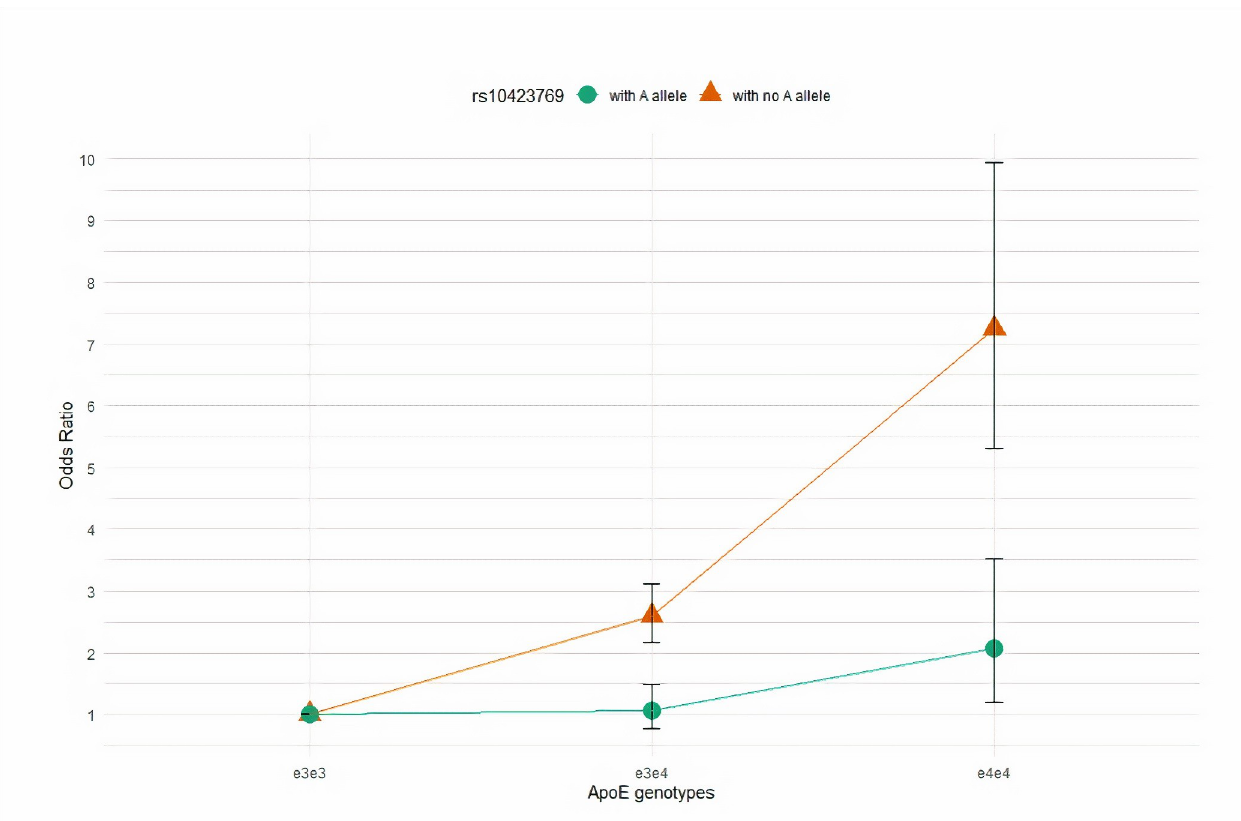
Fig 3. The plot illustrates odds ratios for ε 3/ ε 4 and ε 4/ ε 4 genotypes relative to ε 3/ ε 3 individuals in the combined African American and Ibadan individuals stratified by the rs10423769_A allele. Subgroup odds ratios (95% CIs) are denoted by green color (circle) for rs10423769_A allele carriers and brown color (triangular) for no rs10423769_A allele